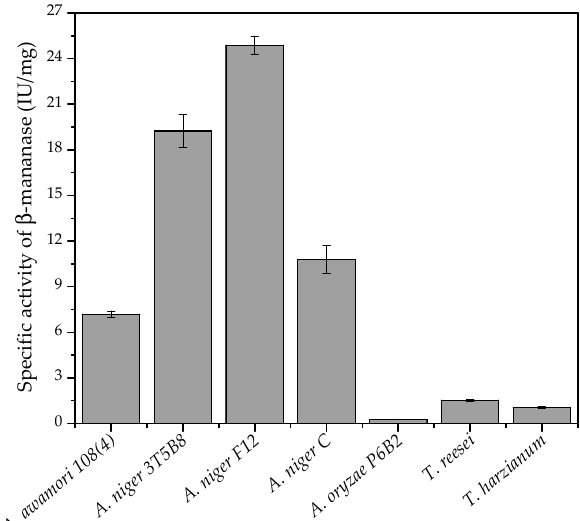
Figure 2. Specific activities of β -mannanase after SSF with different fungi for 120 h at 30 °C, pH 5.0, and 50% ( v / w ) moisture content.